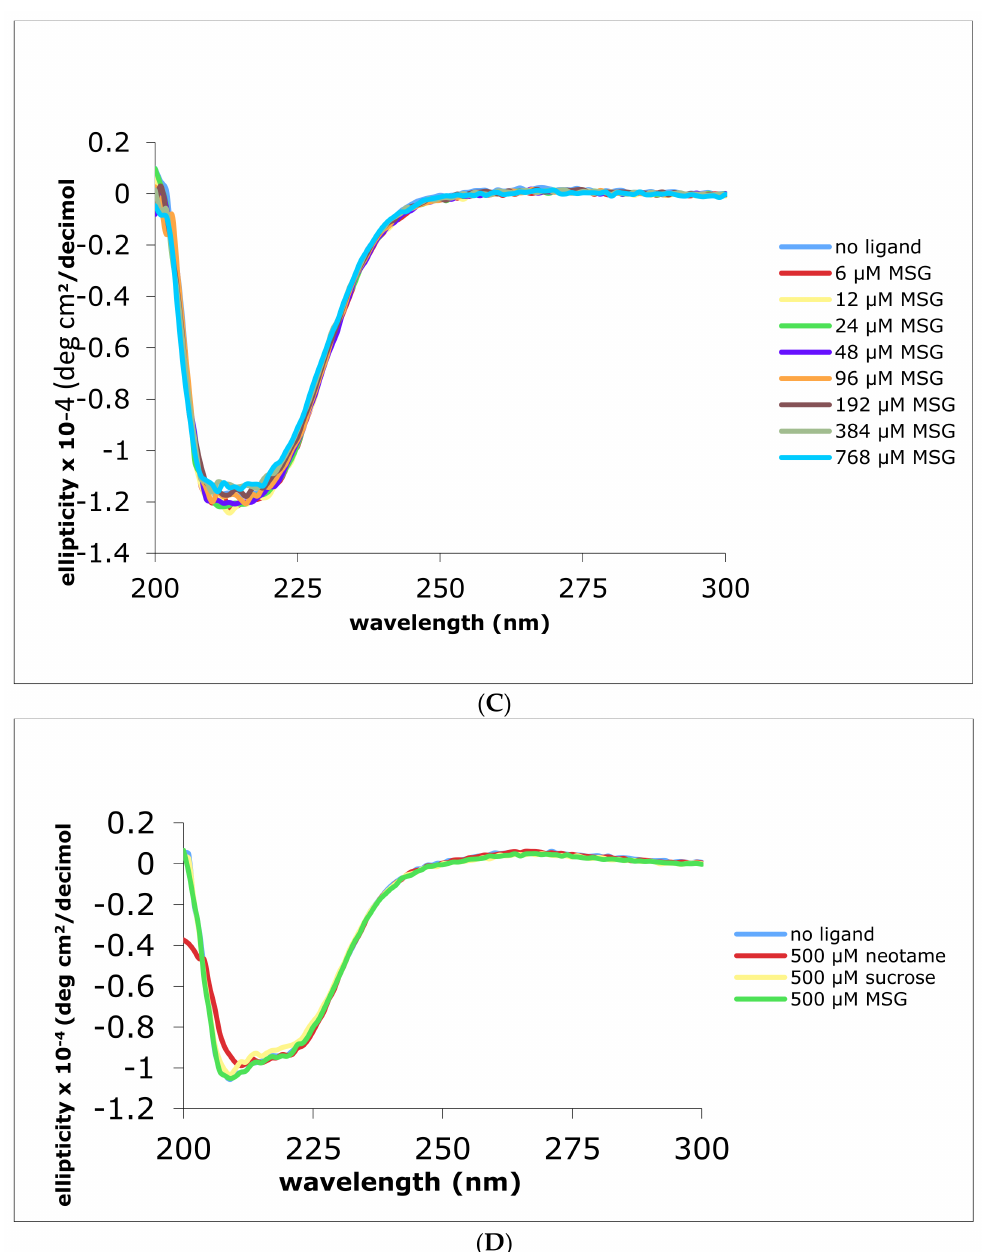
Figure 2. CD spectra of His tagged human and mouse T1R2 ATD ± ligands. Panel ( A ) human T1R2 ATD ± neotame, Panel ( B ) changes in ellipticity at 209 and 219 nm with increasing concentrations of neotame, black symbols are actual data and colored symbols are polynomial-fitted values; panel ( C ) human T1R2 ATD ± MSG; panel ( D ) mouse T1R2 ATD with addition of saturating concentrations of neotame, sucrose, or